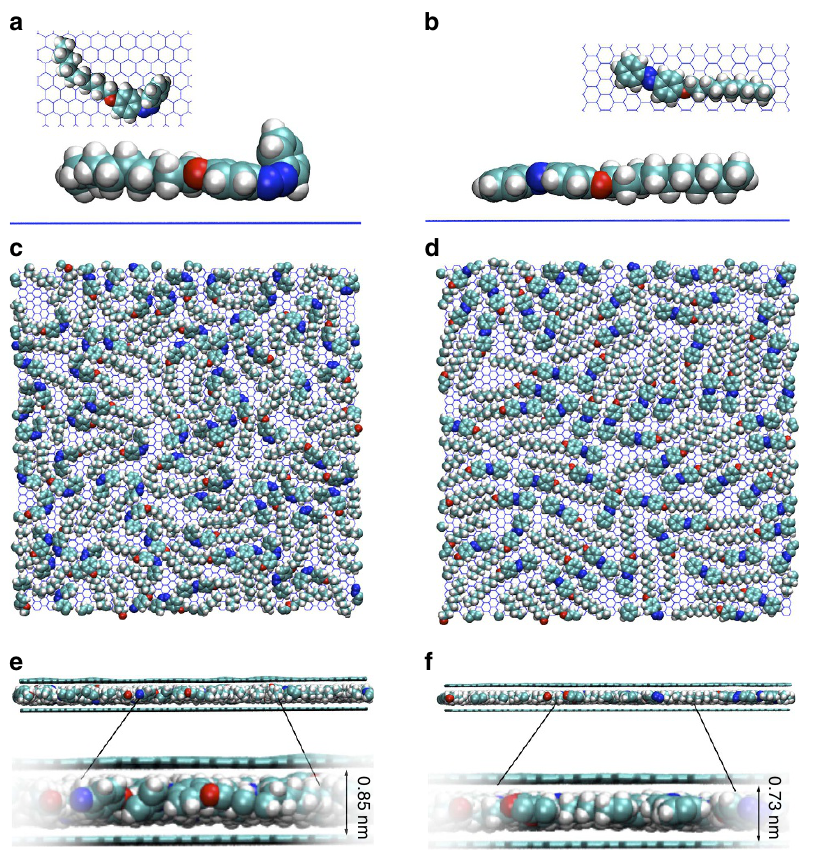
Figure 6 | Molecular modelling of graphene interaction with cis and trans azobenzene. Side and top views of a single ( a ) cis - and ( b ) trans -azobenzene molecule adsorbed on SLG. Top view of the ( c ) cis and ( d ) trans -monolayer, and side view of the molecular system consisting of the ( e ) cis and ( f ) trans -monolayer sandwiched between two SLGs, with the indication of the SLGs